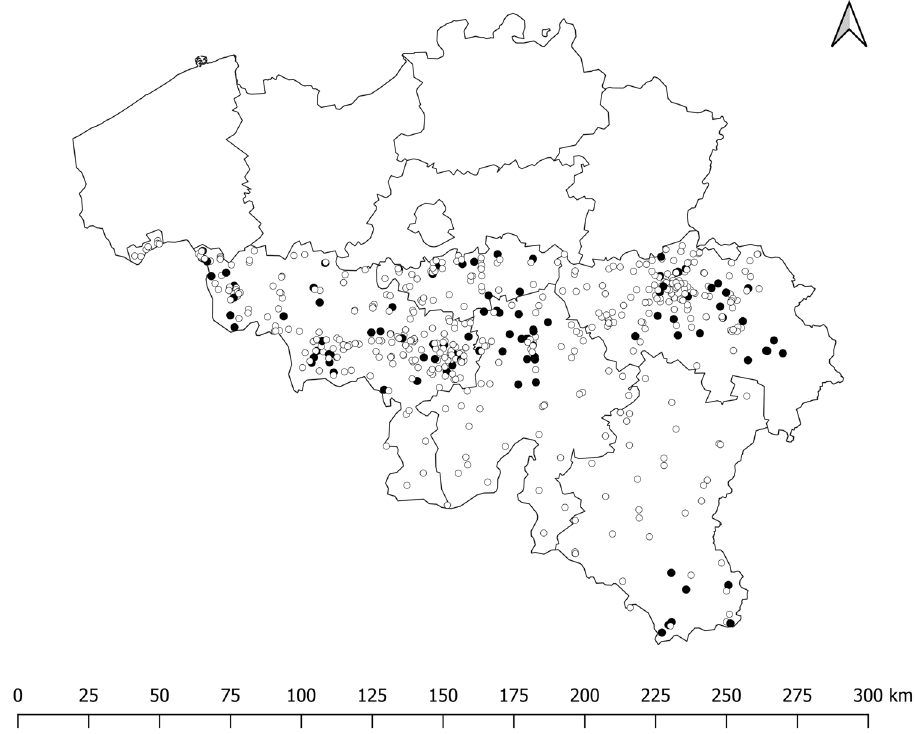
Fig. 2 Participating ( N = 99) and non-participating ( N = 472) nursing homes in the study; map of Belgium, with Wallonia located in the south. Black circles, participating nursing homes; White circles, non-participating nursing homes.